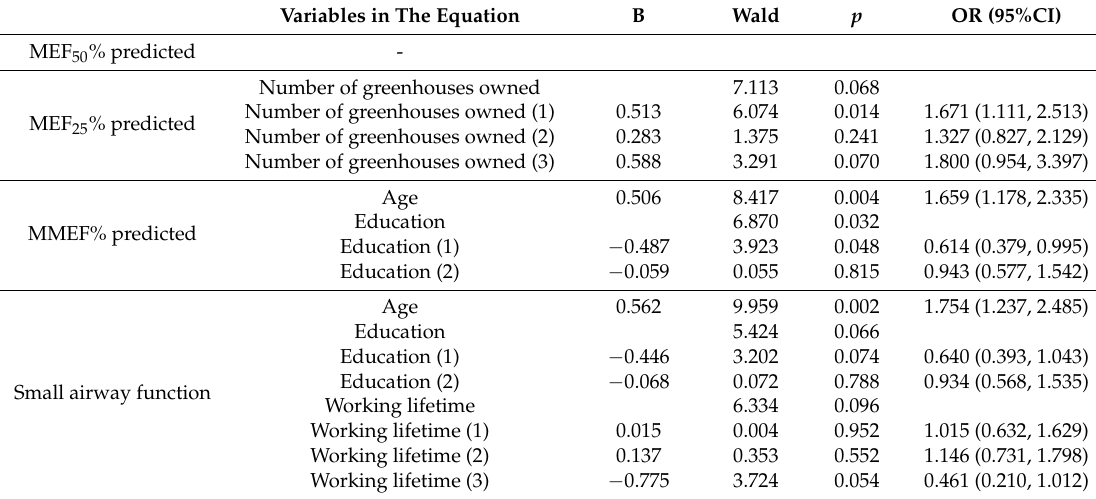
Table 6. Influence factors of small airway function among greenhouse